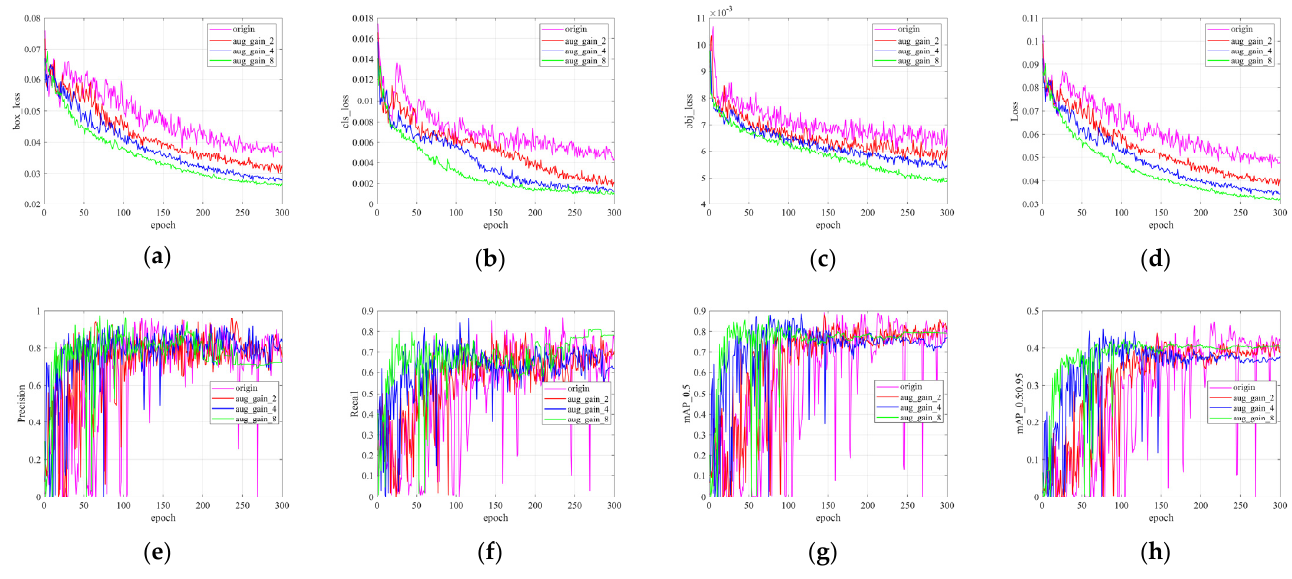
Figure 8. The training details of gain compensation augmentation strategy: ( a ) box_loss ; ( b ) cls_loss ; ( c ) obj_loss ; ( d ) total of three loss; ( e ) precision; ( f ) recall; ( g ) mAP_0.5; ( h ) mAP_0.5:0.95.